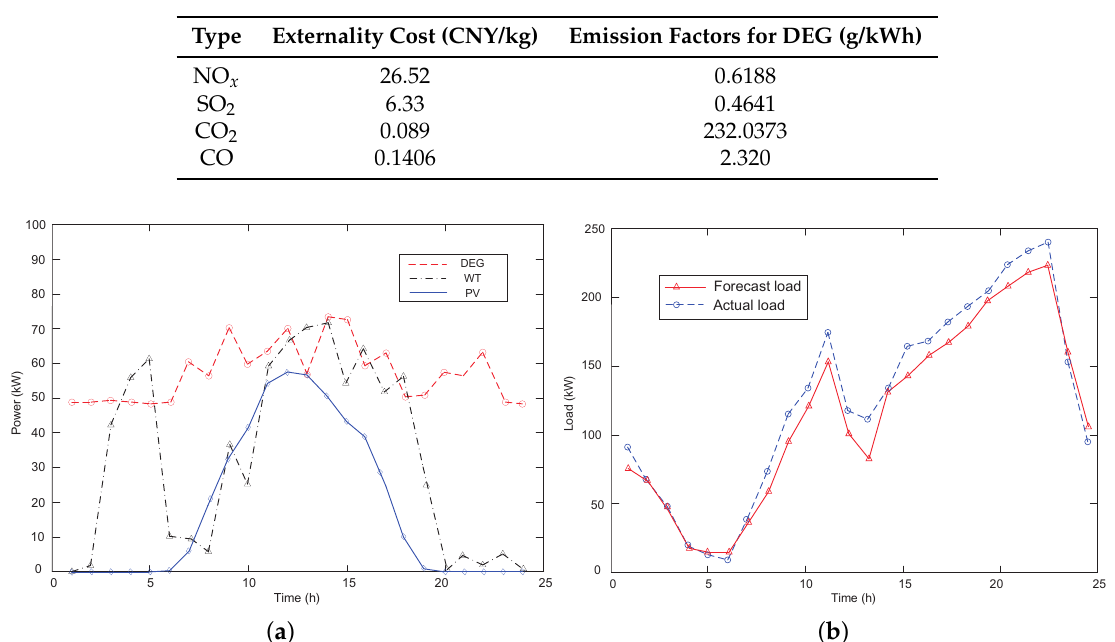
Table 5. Emission cost and emission coefficient of different pollutants.